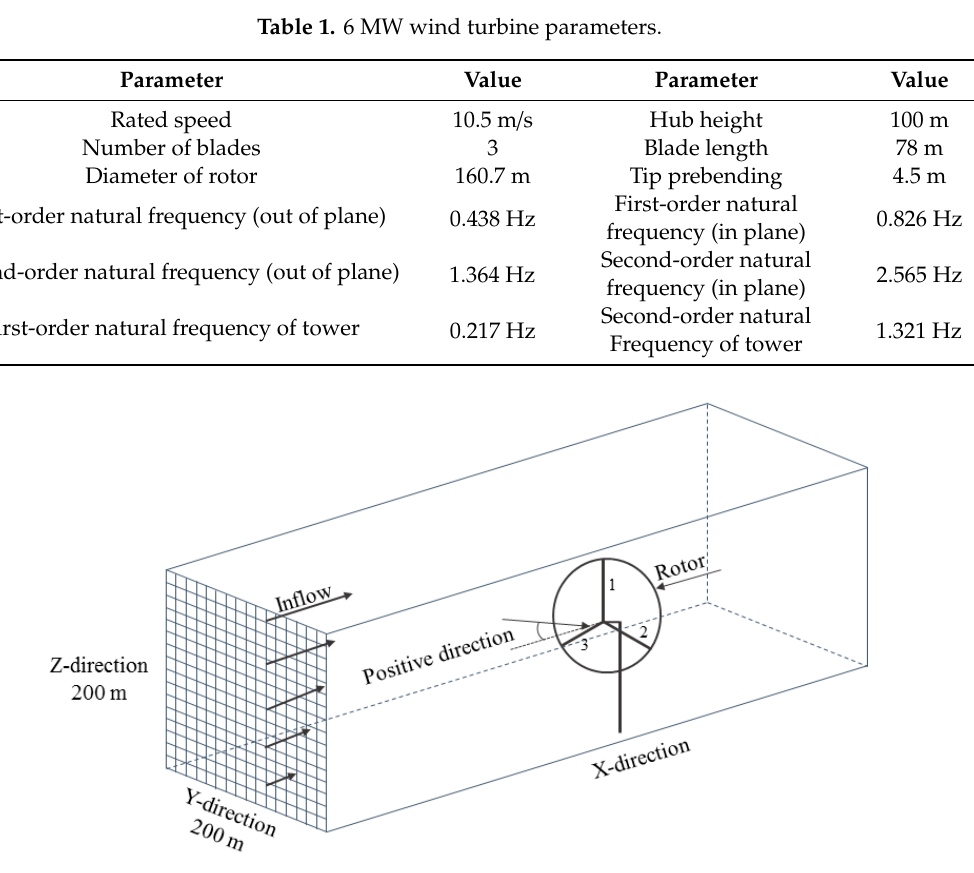
Figure 3. Calculation zone and node partition.